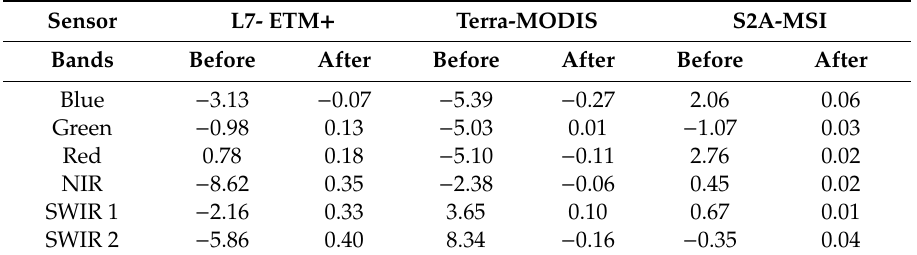
Table 9. Mean Percentage difference of mean TOA reflectance of L8 and the other 3 sensors before and after Scaling Adjustment normalization over Libya 4 site. Sensor